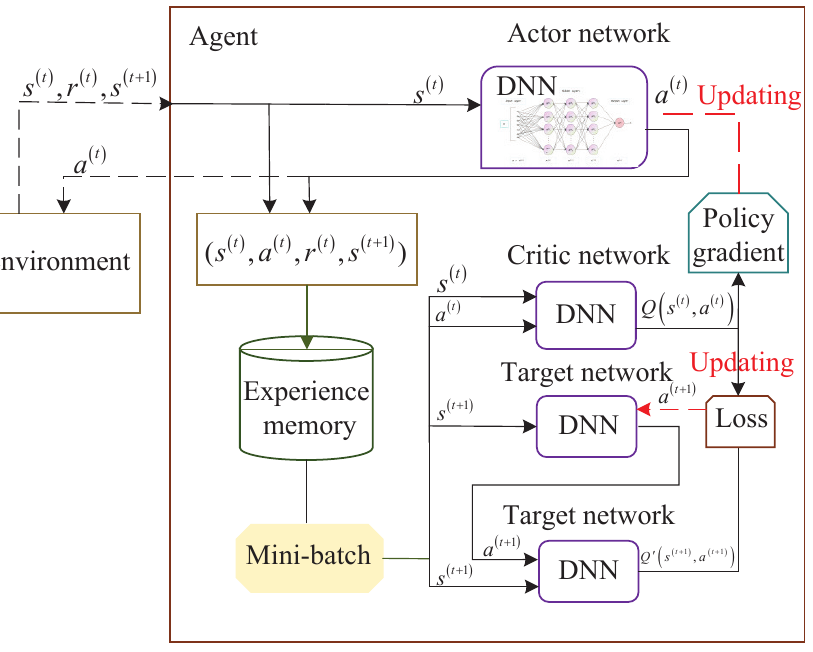
Figure 2. The DRL-based active transmit matrix and phase shift design framework using